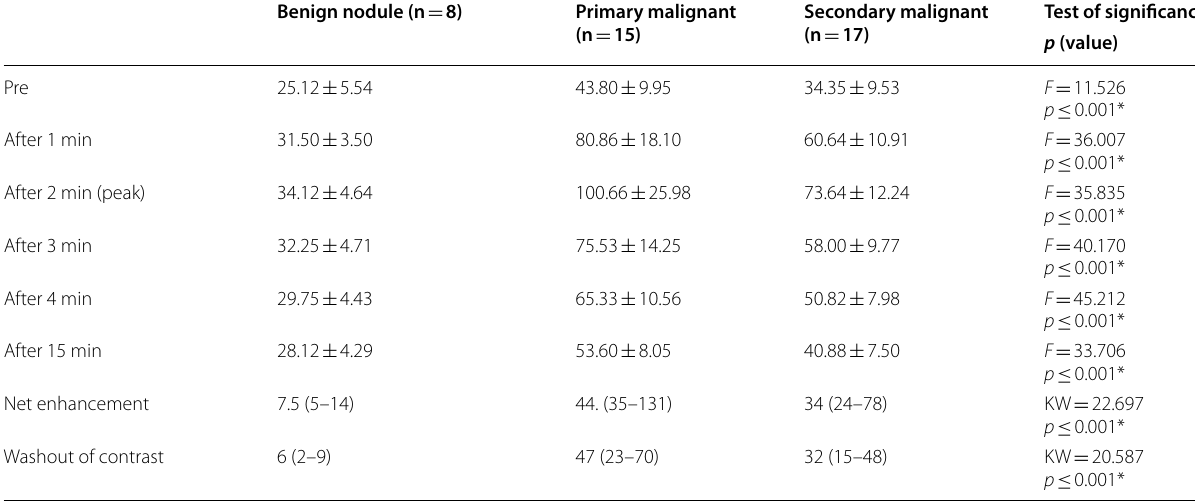
KW, Kruskil wallis test